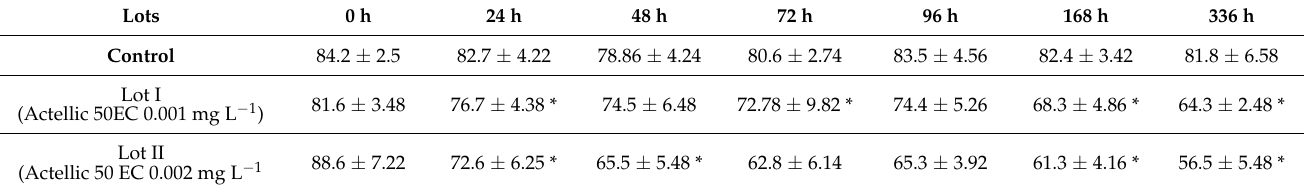
Table 5. Variations in the average respiratory rate (breaths/minute) and the standard deviation of the Prussian carps exposed to Actellic 50 EC insecticide at different concentrations.